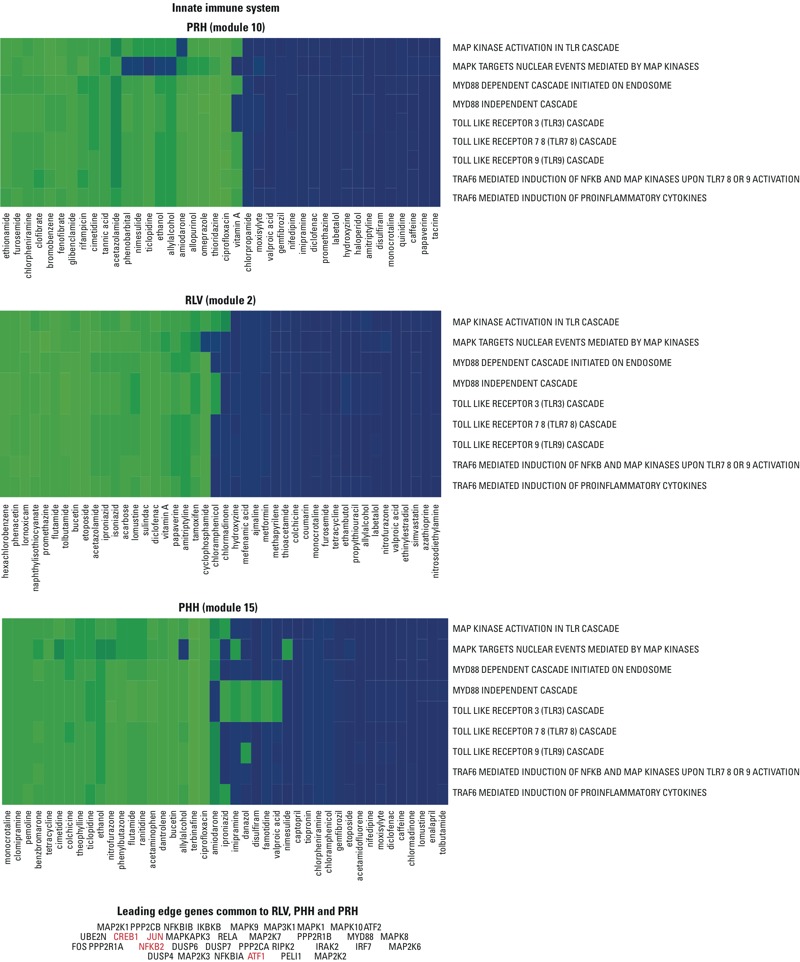
Conservation of modules across in vitro and in vivo settings based on Reactome pathways. This example summarizes a conserved module between RLV, PRH, and PHH, shown as heatmaps and keeping overlapping pathways colored with respect to their enrichment scores: up-regulated pathways are shown in blue, and down-regulated pathways are shown in green. The three heatmaps correspond to a conserved module associated with the innate immune system (mod2 in RLV, mod15 in PHH, and mod10 in PRH). The leading edge genes from common pathways that areactivated or repressed by chemicals are shown under the heatmap with known oncogenes colored in red. (For more details, see Supplemental Material, Zip files S2 and S4.)